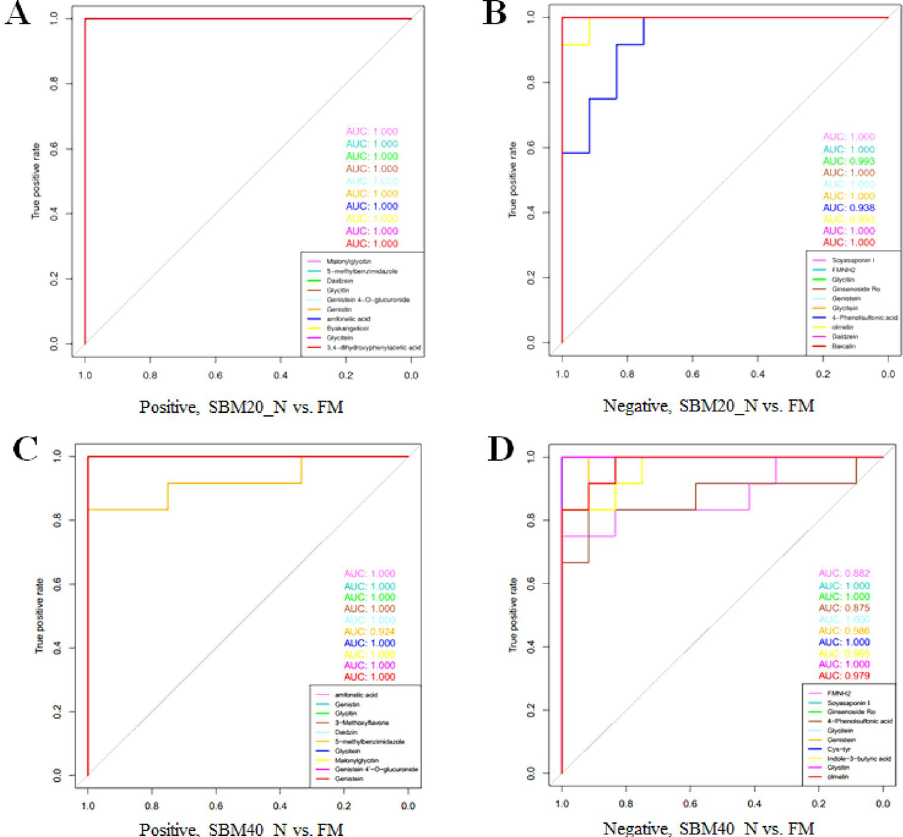
Figure 17. ROC analysis for discrimination among the groups for the potential biomarker metabolites in positive ( A , C ) and negative ( B , D ) modes (n = 12). Note: FM_N, fish meal control group; SBM20_N, 20% SBM protein replacement level to FM protein; SBM40_N, 40% SBM protein replacement level to FM